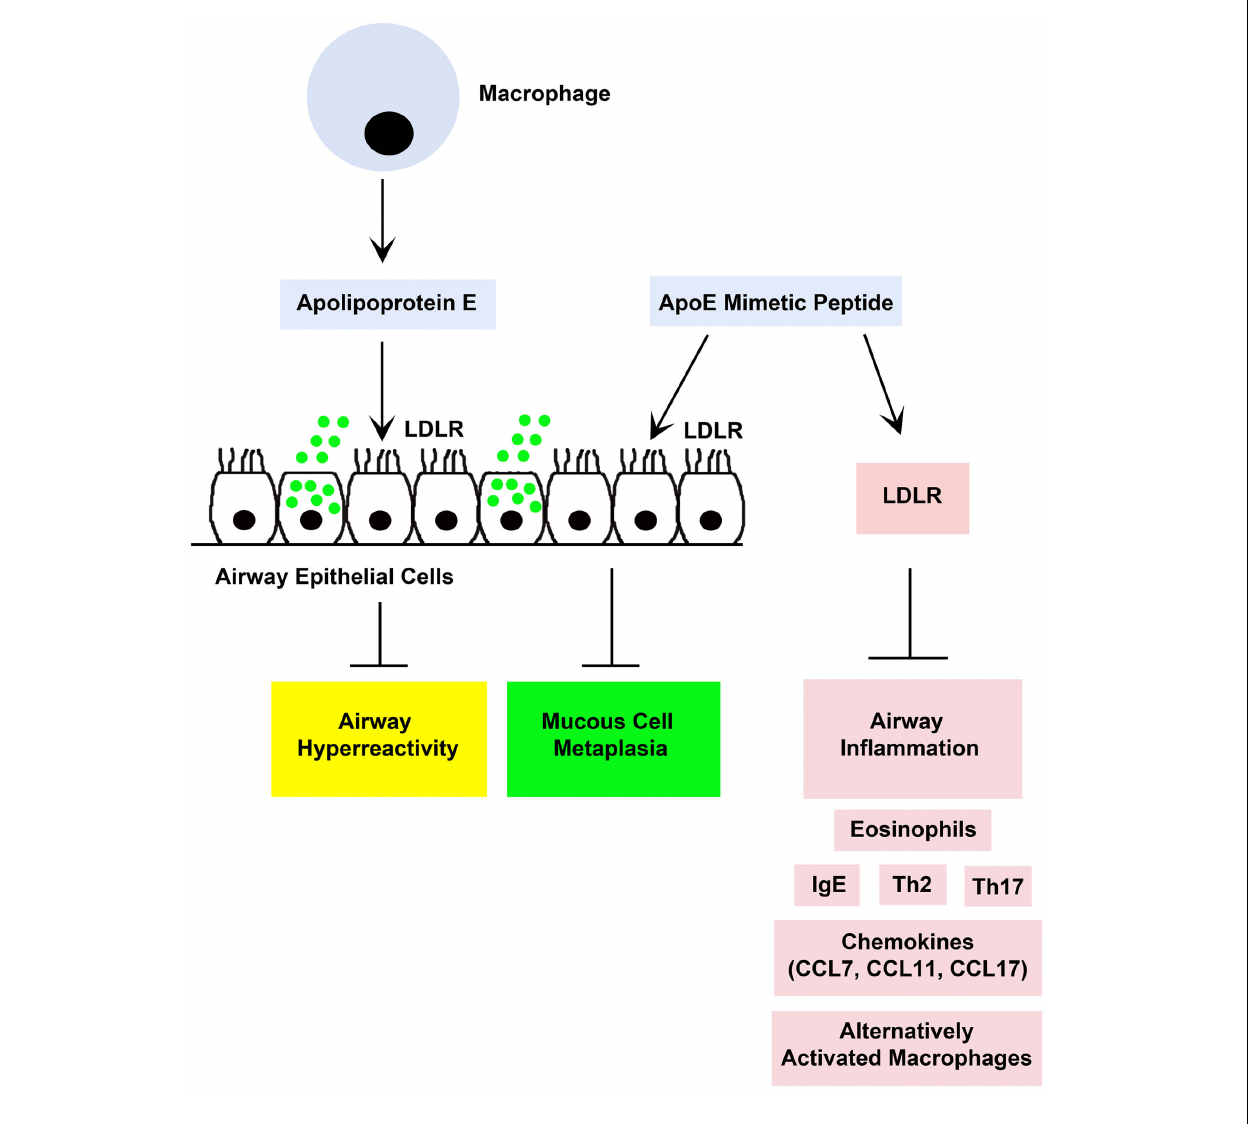
interaction with low density lipoprotein receptors (LDLR), such as those expressed by ciliated airway epithelial cells. Although endogenous apoE did not modulate HDM-induced airway inflammation, administration of the apoE(130–149) mimetic peptide attenuated airway inflammation in apoE knockout mice, but not in LDLR knockout mice, which suggests that the anti-inflammatory effects of the apoE(130–149) mimetic peptide are mediated via a LDLR-dependent